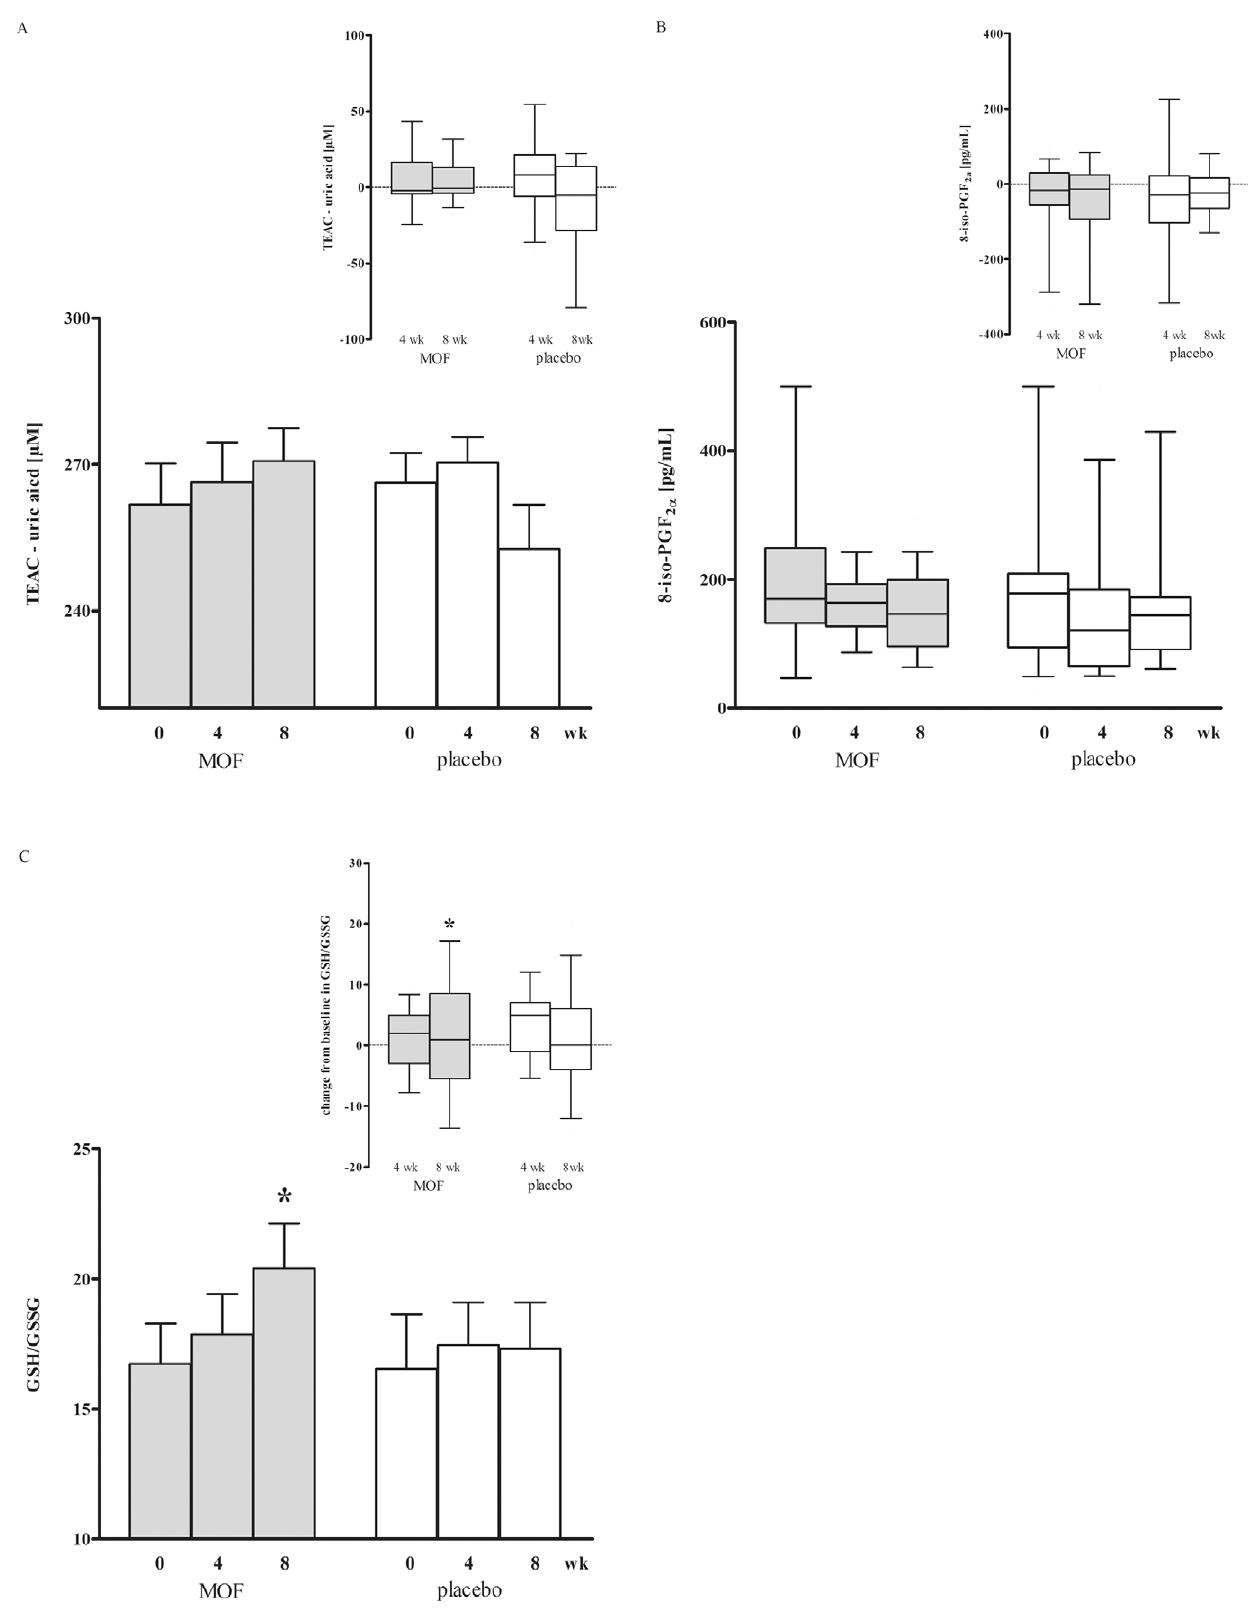
Figure 3. Mean ± SEM (bars) or median (10 th and 90 th percentile) (box and whiskers) antioxidant capacity of plasma measured as trolox equivalent antioxidant capacity (TEAC) and corrected for uric acid plasma concentrations (A), ratio of glutathione (GSH) to